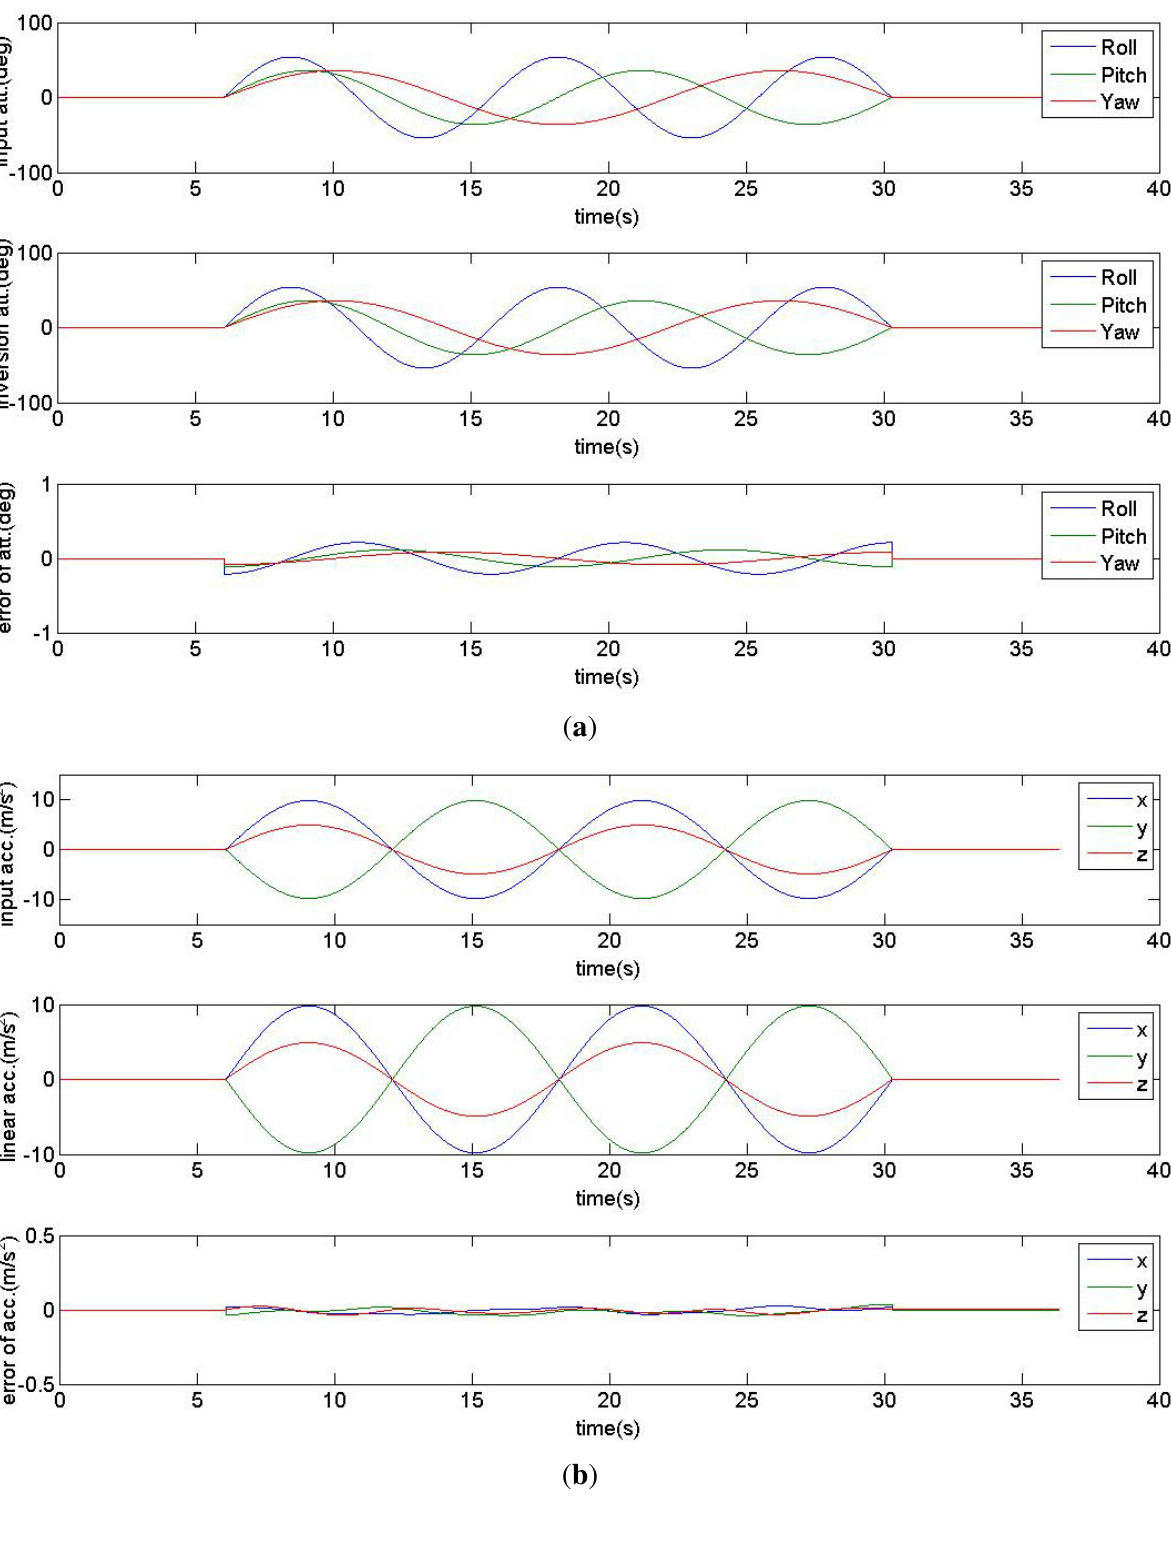
Figure 5. Inversion results of simulated data. The top, middle and bottom curves in ( a ) are the input data, inversion data and errors of the roll, pitch and roll attitudes, respectively. The top, middle and bottom curves in ( b ) are the input data, inversion data and errors of the x-, y- and z- linear accelerations,